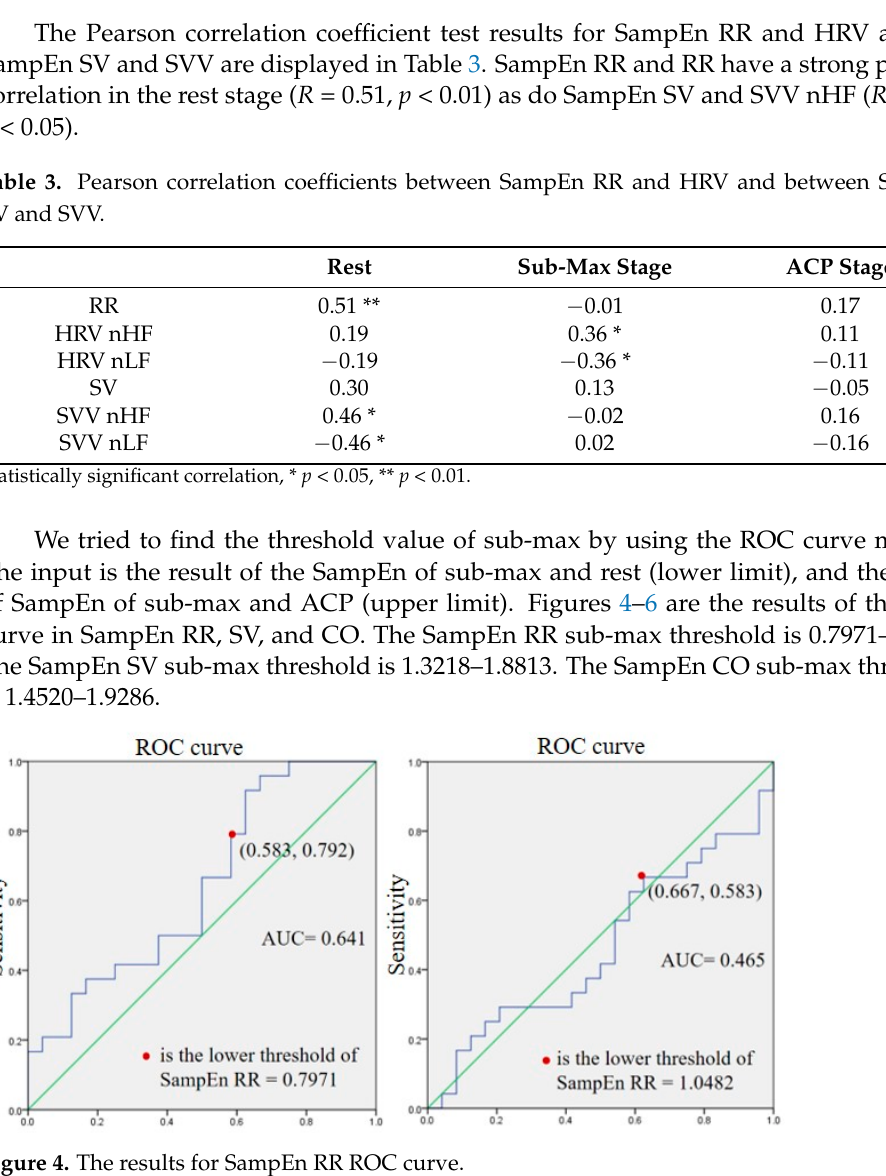
Figure 5. The results for SampEn SV ROC curve. Figure 6. The results for SampEn CO ROC curve. 3.2. Breathing Results The BR and SampEn BB results are presented in Table 4. Four of the thirty partici- pants were excluded due to excessive noise in their breathing signals. Therefore, the total